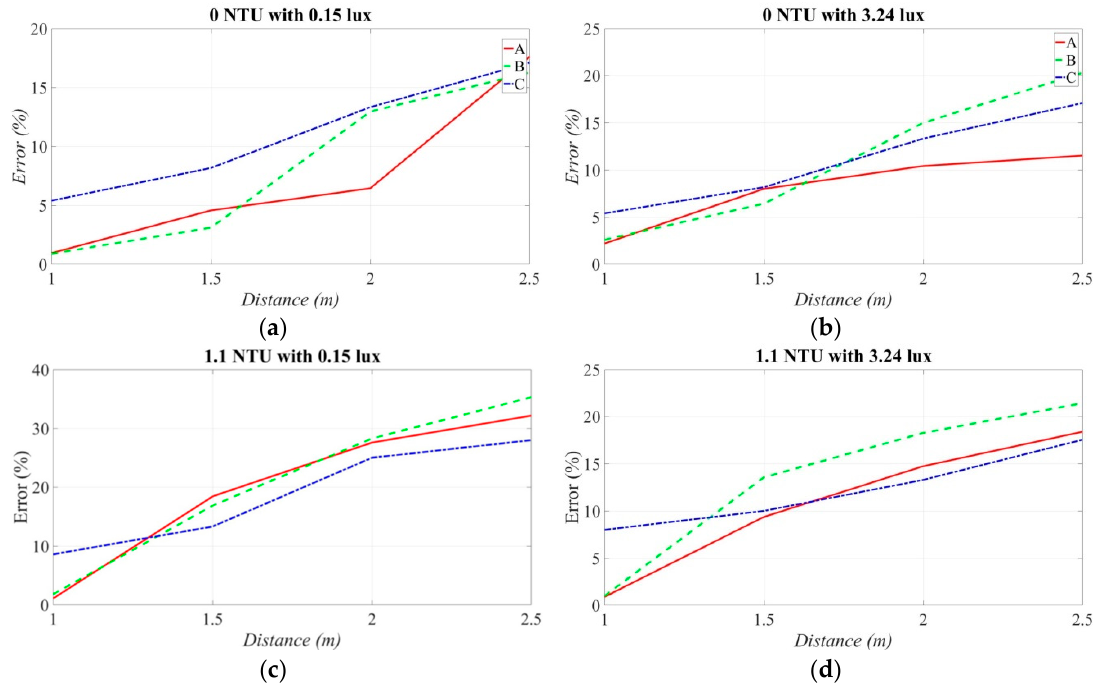
Figure 29. Comparison of error rates of (A) bow, (B) midship, and (C) stern measured at four different distances in the condition of ( a ) 0 NTU and 0.15 lux; ( b ) 0 NTU and 3.24 lux; ( c ) 1.1 NTU and 0.15 lux; and ( d ) 1.1 NTU and 3.24 lux, respectively.